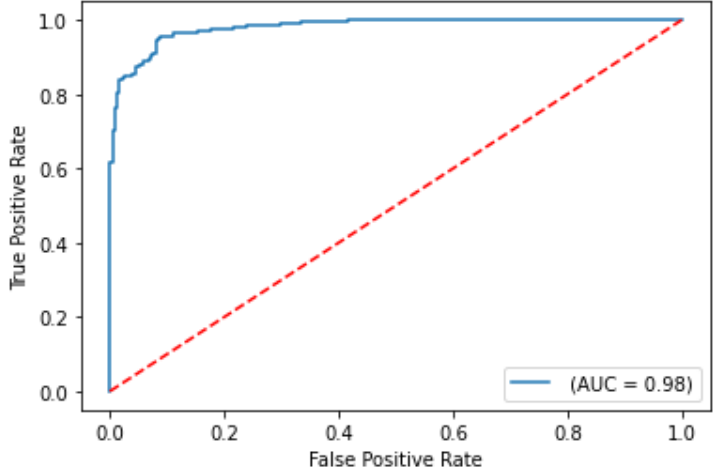
Table 1. Evaluation metrics for COVID-19 severity and survival models.